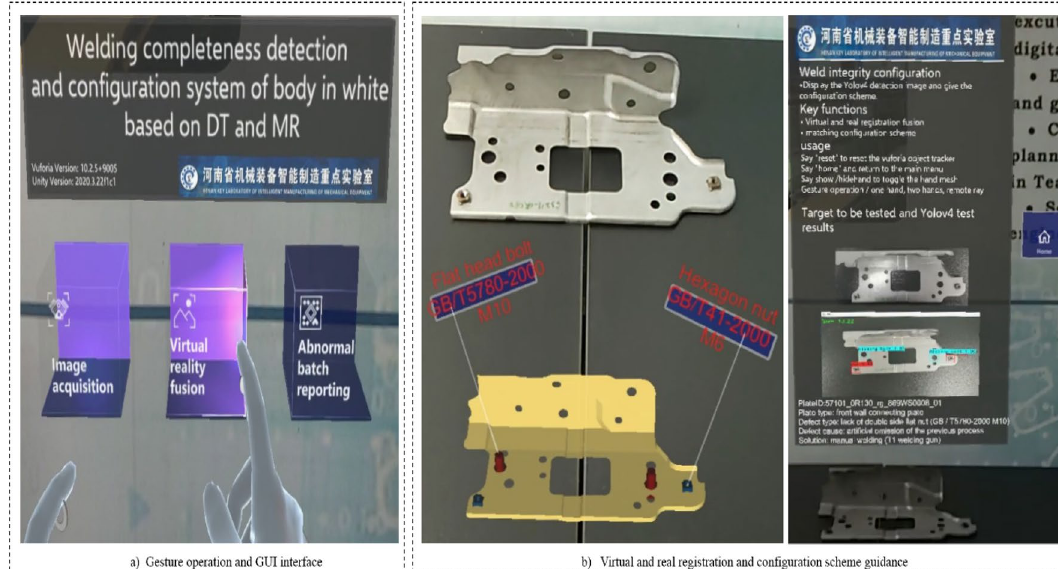
Figure 7. Panel welding completeness configuration.